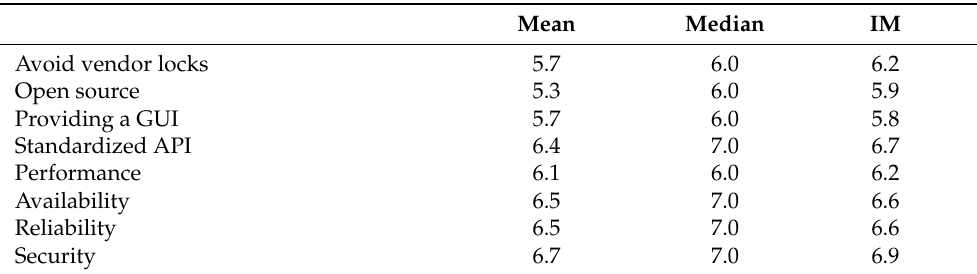
Table 2. Means, medians and interpolated medians of answers to questions prefaced by: How important is the following property for you when you operate an IoT platform?